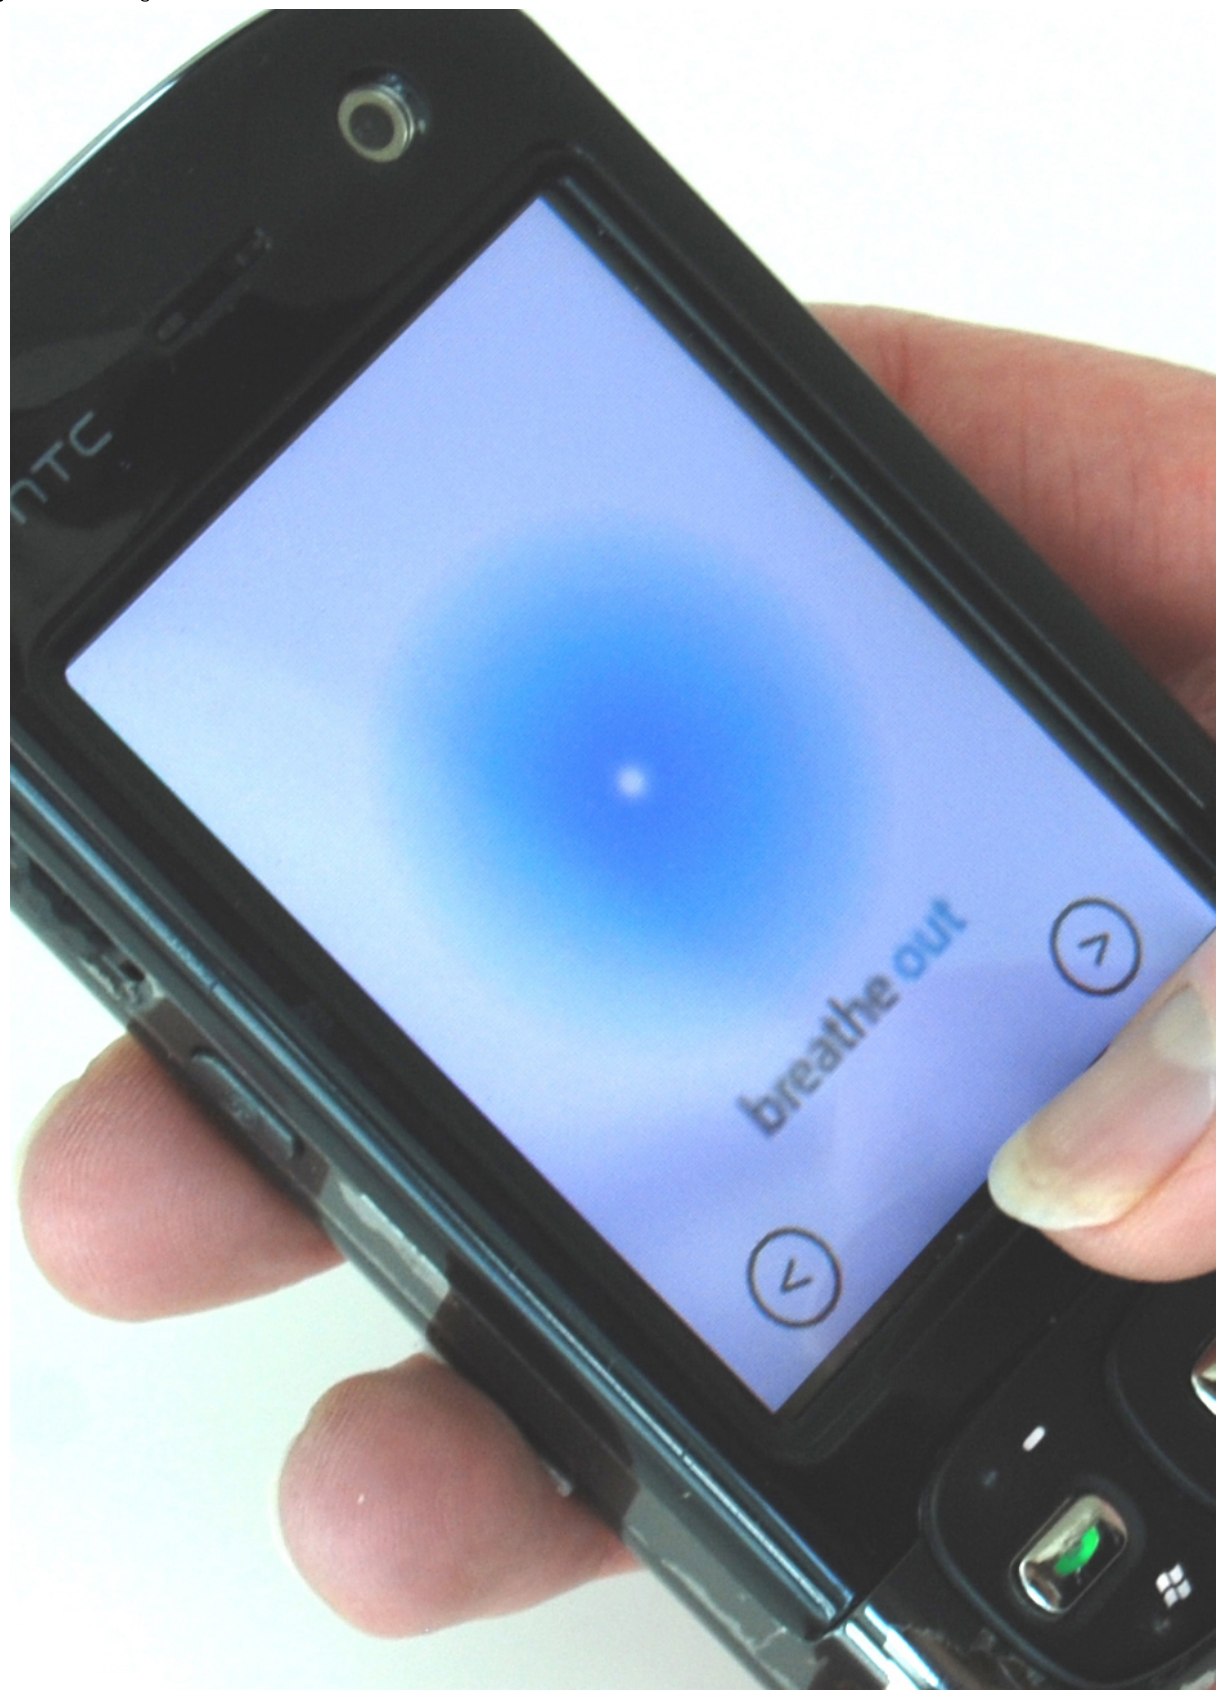
Figure 3. Breathing